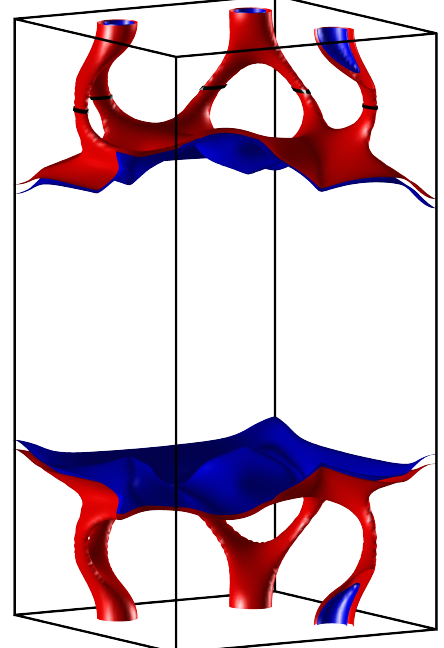
Figure 5: Topology of one of the f -core Fermi surface sheets obtained from uncorre- lated DFT calculations. This sheet is displayed in blue for the Fermi energy obtained by the DFT calculations. Necks are connected in the f -core DFT calculations if the Fermi energy is shifted by − 1.5 meV. Electron orbits at the neck are highlighted in